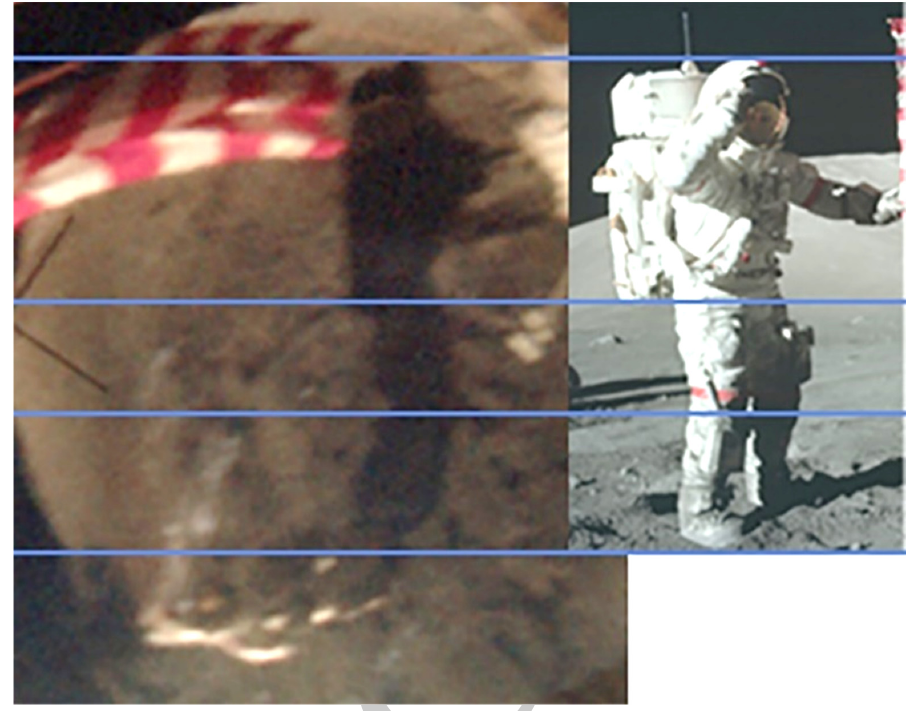
Figure 18. Comparison of the shadow of the astronaut shown in the helmet reflection of photo AS17-134-20384 and the astronaut imaged in photo AS17-134-20386 indicates that the astronaut is taking the photo in a standing position. The corresponding blue lines indicate the various parts of the body.